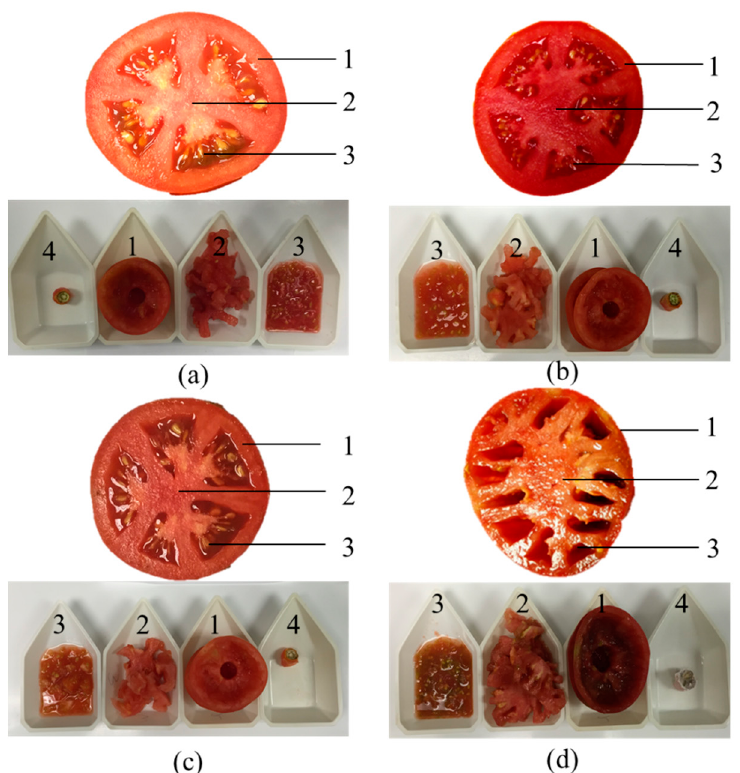
Figure 1. Schematic cross-section of ( a ) Tasti-Lee, ( b ) Tygreen, ( c ) FL47, and ( d ) Cherokee Purplea tomato fruit. (1) Pericarp (PE); (2) septa and columella (SC); (3) locular gel and seeds (LS); and (4) stem end (SE).